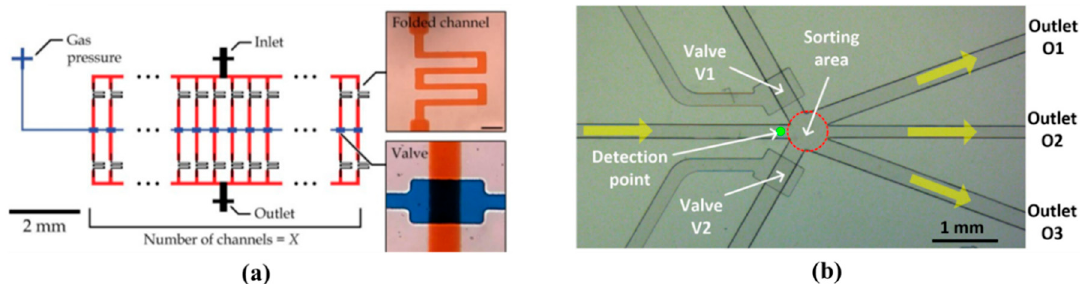
Figure 10. Applications of multiple pneumatic microvalves: ( a ) Integrated microfluidic device containing 100 microvalves [73]; ( b ) Micro-droplet sorter with two pneumatic microvalves [80].